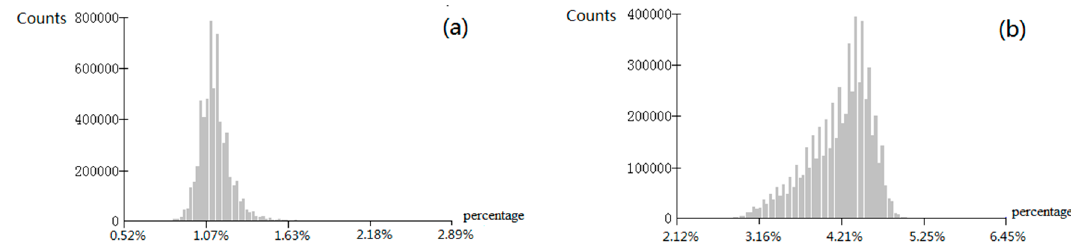
Figure15. Histogramsforthe( a )maximumpercentageincreaseand( b